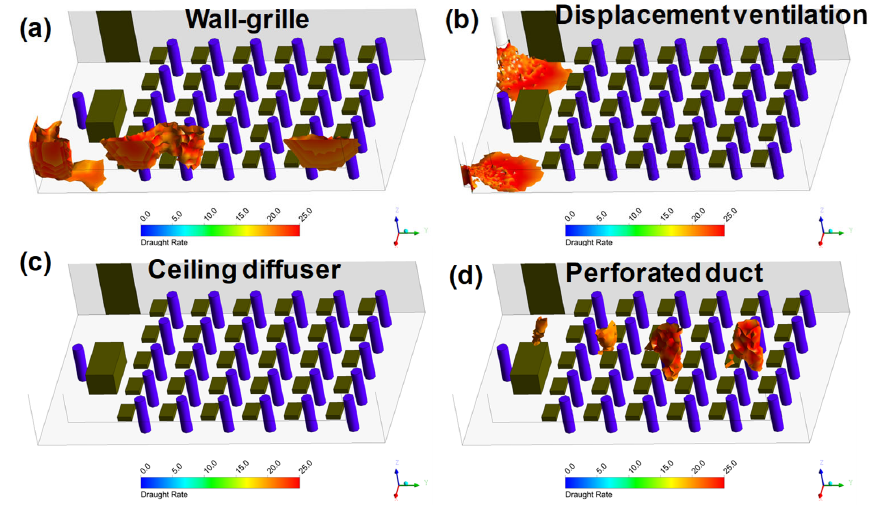
Figure 14. Draft rate of more than 20% in summer conditions.